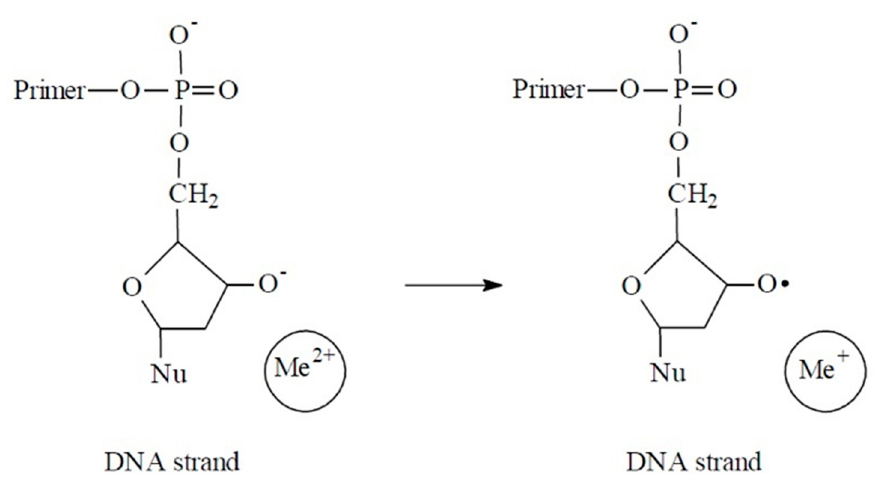
Figure 1. A reaction of electron transfer from the nascent DNA deoxyribose anion to a bivalent metal ion.